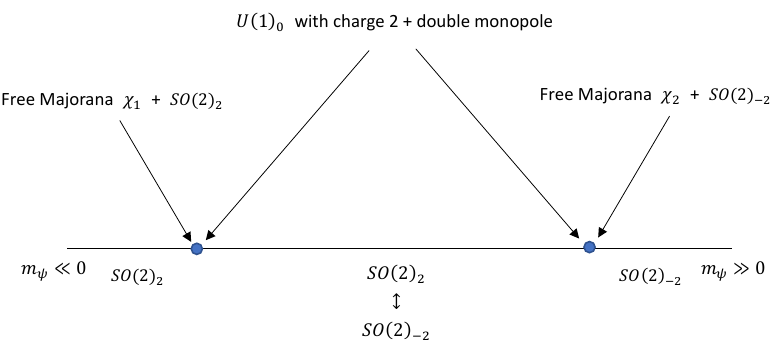
Figure 1: The phase diagram of U ( 1 ) gauge theory coupled to a Dirac fermion with charge two, together with a double monopole perturbation. The monopole perturba- tion splits the free Dirac point into two Majorana points. These transitions separate